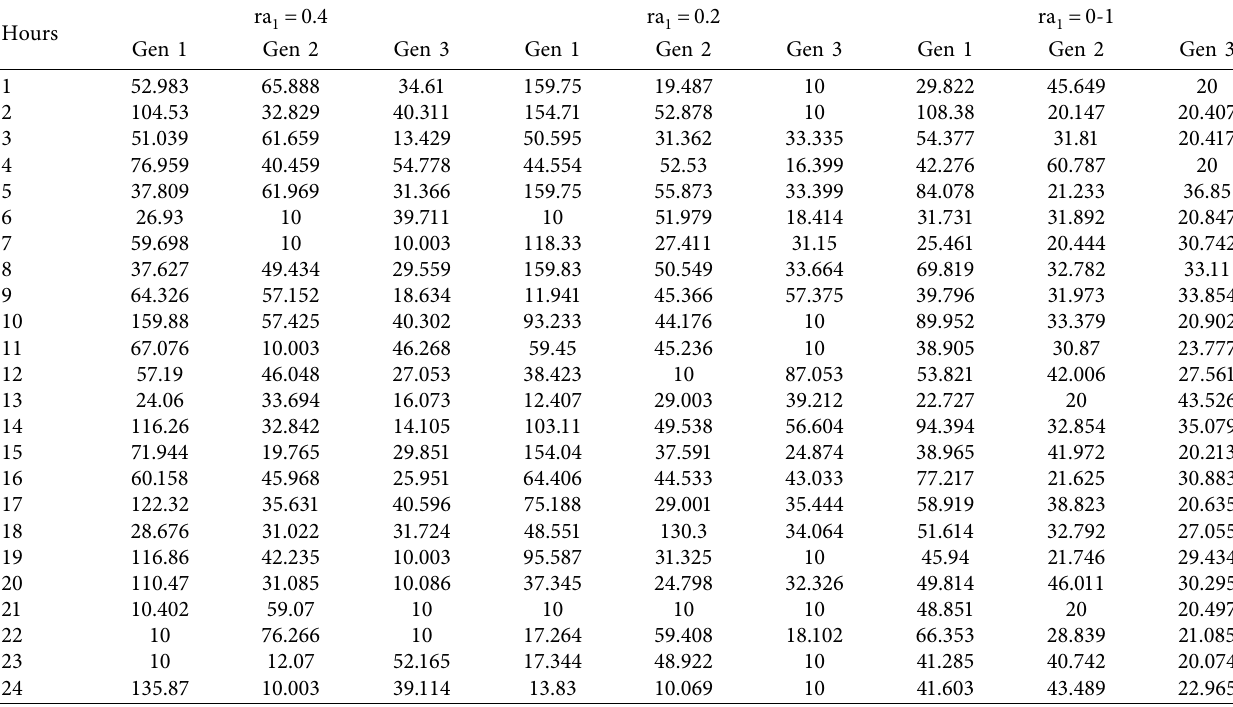
� 0.4, ra � 0.2, and ra � 0-1. 1 1 1